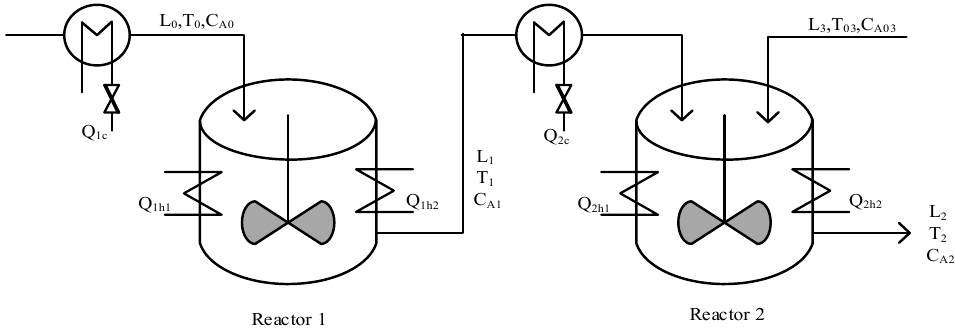
Figure 4. Schematic of continuous stirred tank reactors (CSTRs). Table 1. Process parameters and steady-state values of CSTRs.